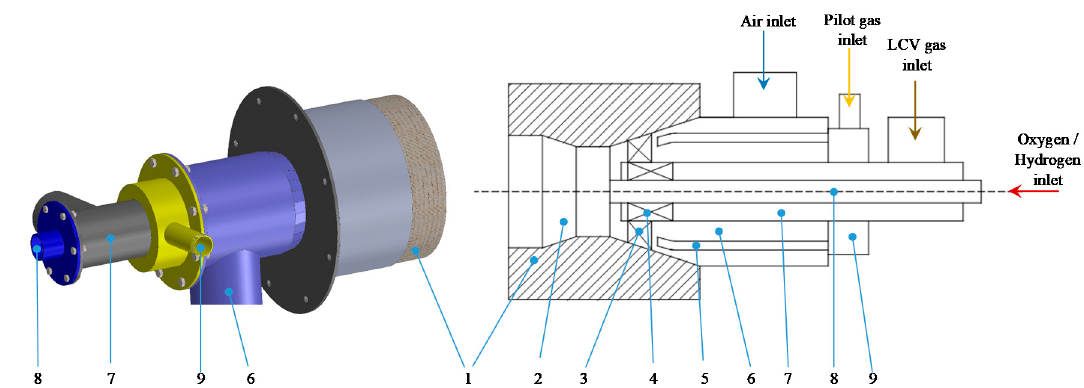
Figure 2. Schematic view of the experimental LCV gas burner:1–A burner embrasure; 2–a burner quarl; 3–an axial airflow swirler; 4–an axial LCV gas swirler; 5–a pilot gas lance; 6–an air annulus; 7–an LCV gas annulus; 8–an oxygen or hydrogen orifice; 9–a pilot gas annulus. The flame stabilization is achieved by swirling both, the combustion air and LCV gas flow with an axial vane swirl angle of 30°. Both swirlers has a swirl number of S w = 0.5, which was defined by Equation (1) [28]: